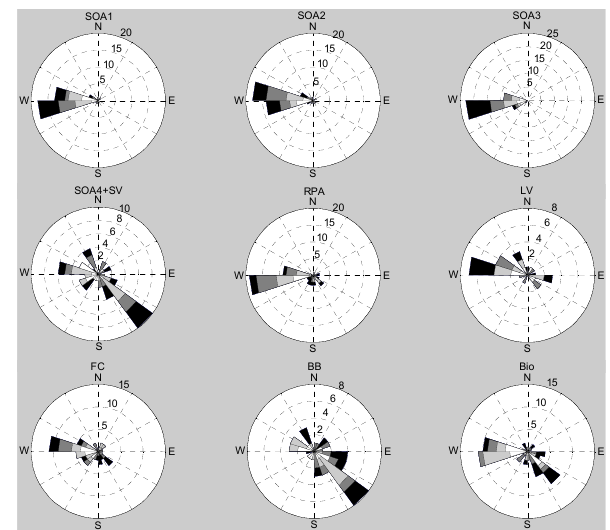
Fig. 12. Rose plots of the 9 summer PMF factors using only factor concentrations > 1 standard deviation of mean factor concentration to emphasize dominant source directions. Frequency of observa- tions are represented by the length of each wedge, and labeled by concentric rings. The shade of each wedge represents source con- centrations in quartiles (dark=higher concentrations).